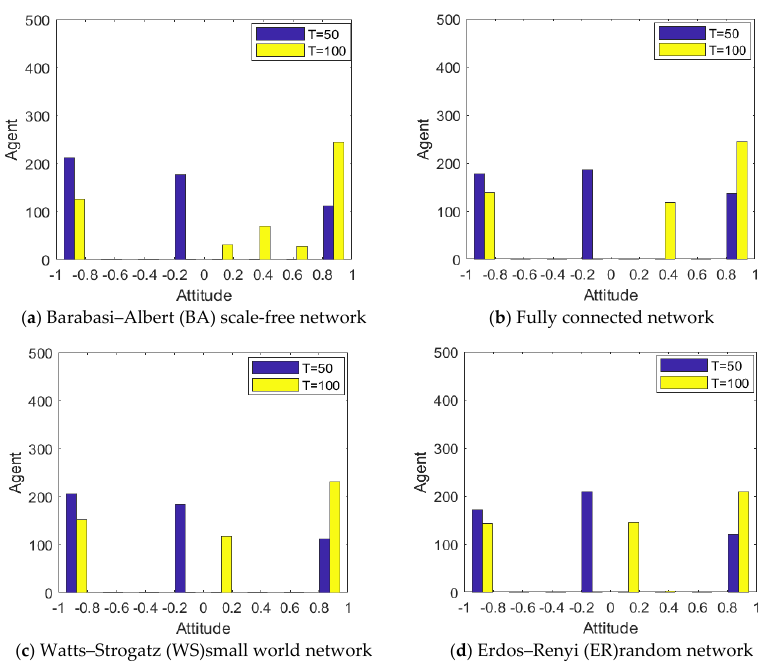
Figure 26. Distribution histogram of group attitude under different networks.( a ) BA scale-free